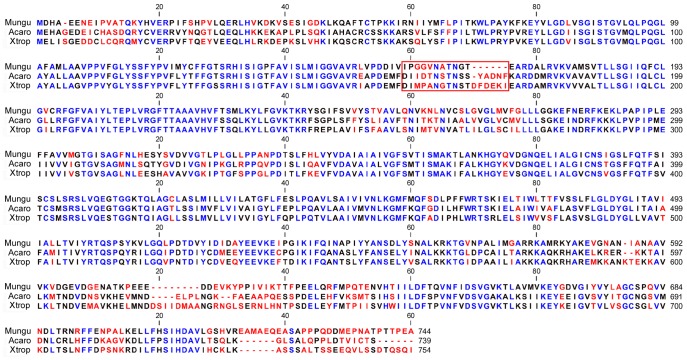
Alignment of consensus amino acid sequences of SLC26A5 of gerbil (Meriones unguiculatus, Mungu), frog (Xenopus tropicalis, Xtrop) and anole lizard (Anolis carolinensis, Acaro).Color of each residue represents identity at the residue among three different species. Blue: Full identity at a residue; Black: Partial identity (2/3 sequences) at a residue; Red: complete disparity at a residue. Gaps in the aligned sequences are indicated by the dashed line. The red box marks the motif that is remarkably conserved among mammalian species but highly variable among non-mammalian orthologs. This area may reflect a structural adaptation that facilitates gain of motor function in mammalian prestin.